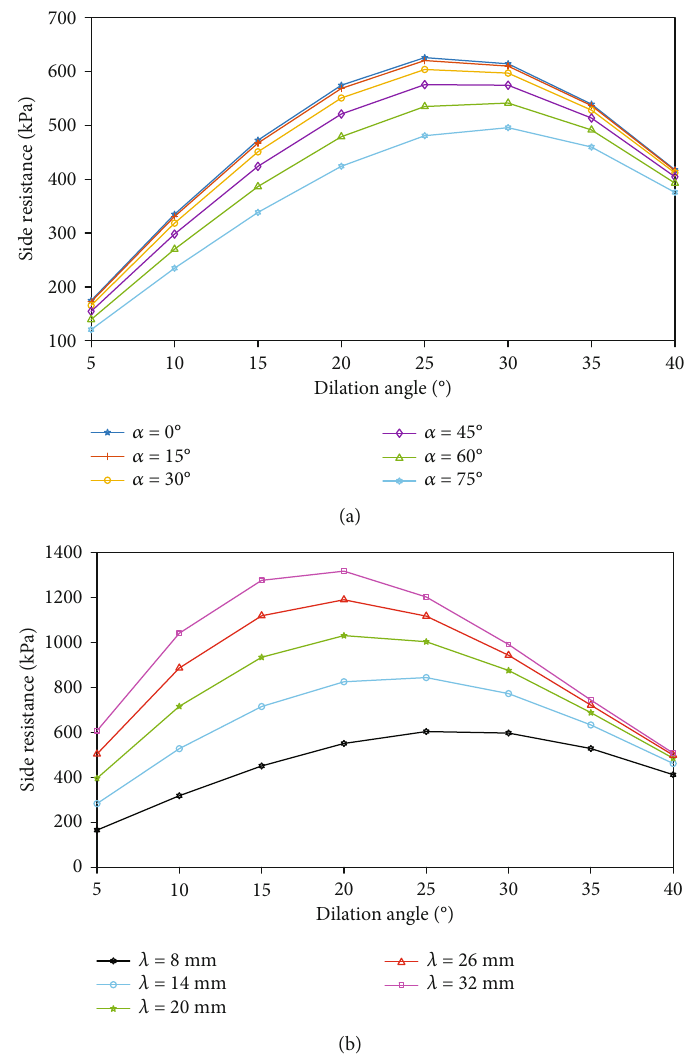
Figure 8: The in fl uence of slope angle and interface roughness on residual unit side resistance: (a) the in fl uence of slope angle; (b) the in fl uence of the half-chord